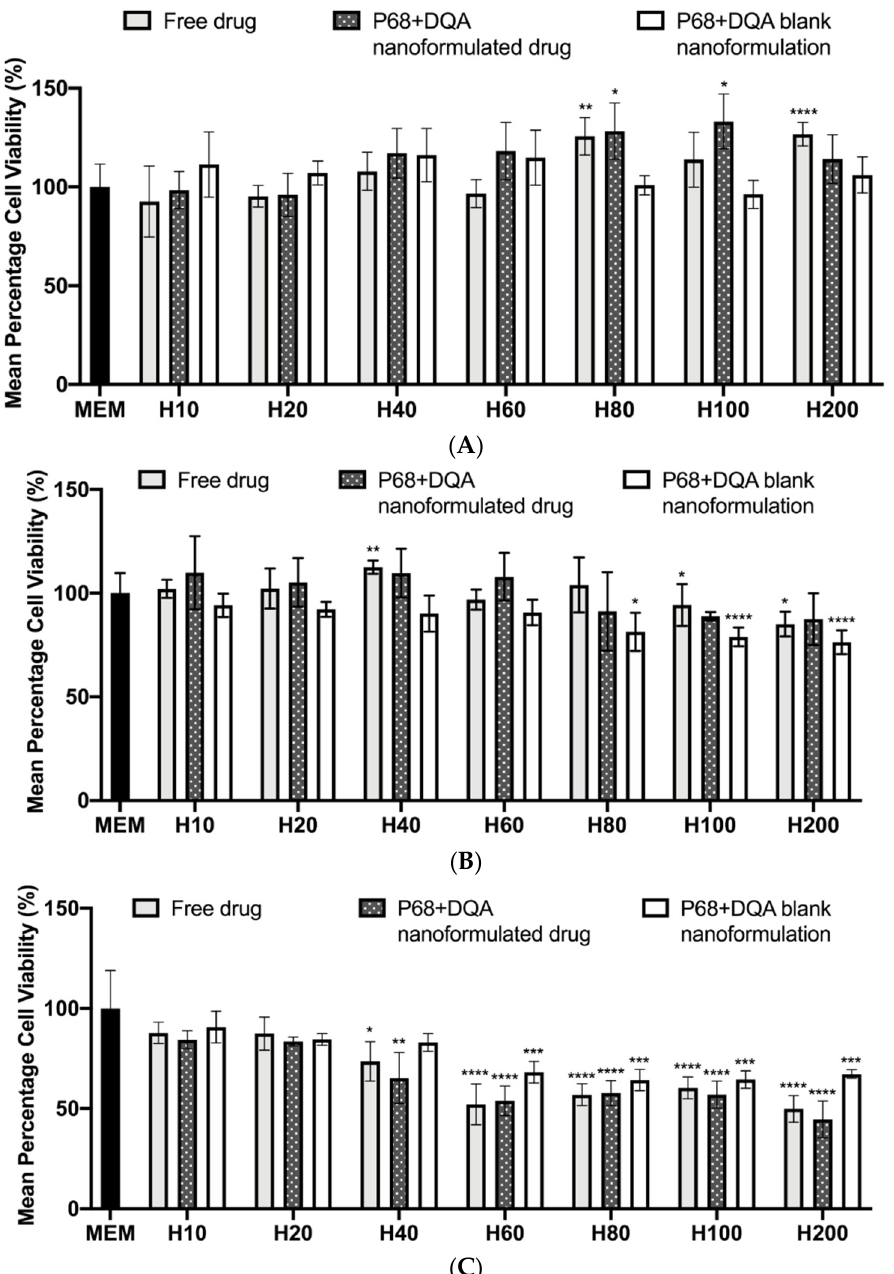
Figure 4. ( A ) MTT assay results of 24 h 10–200 μ M HT treatment. MEM represents the control condition, cells only treated with media (mean ± S.D., n = 6). ( B ) Corresponding MTT assay results for 48 h HT treatments. ( C ) Corresponding MTT assay results for 72 h HT treatments. * represents significance values of the treatment conditions compared to the control condition (**** p < 0.0001, *** p < 0.001, ** p < 0.01, * p < 0.05).